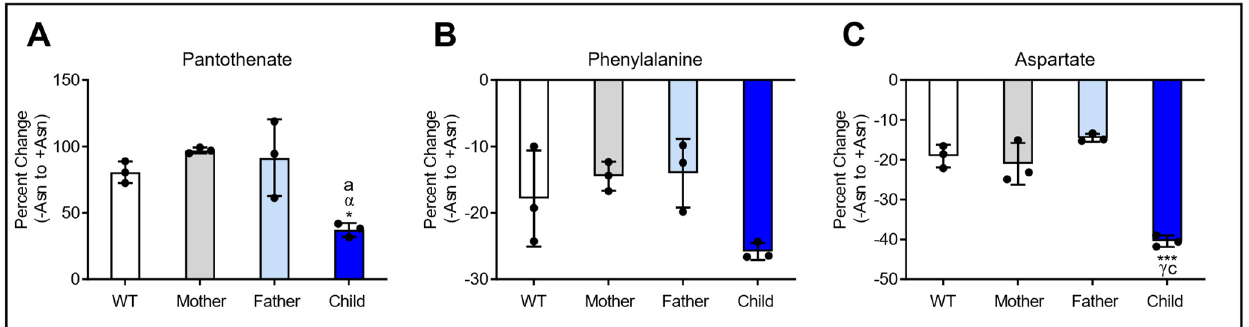
Figure 5. Signature metabolic differences found across LCL and fibroblasts challenged with Asn deprivation. Data are presented as the percent change between +Asn and − Asn media conditions for each cell line. Pantothenate ( A ) and phenylalanine ( B ) were both altered in all LCL lineages, and aspartate ( C ) was decreased in all fibroblast cell lines. The data are shown as means ± SD and statistical significance was established by ANOVA with Tukey post-hoc analysis and is represented as: (*) if p ≤ 0.05 and (***) if p ≤ 0.001 compared to WT. ( α ) if p ≤ 0.05 and ( γ ) if p ≤ 0.001